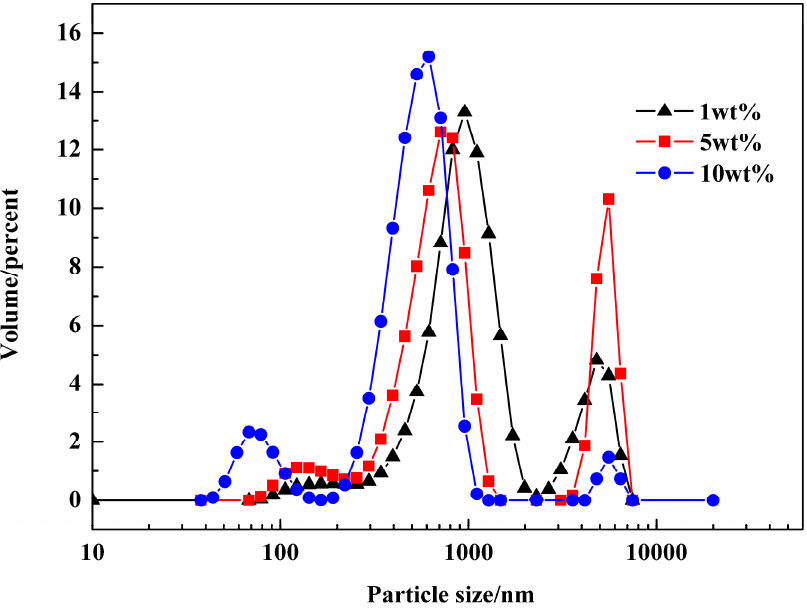
Figure 8. Size distributions of macroemulsions containing different dosages of emulsifier.